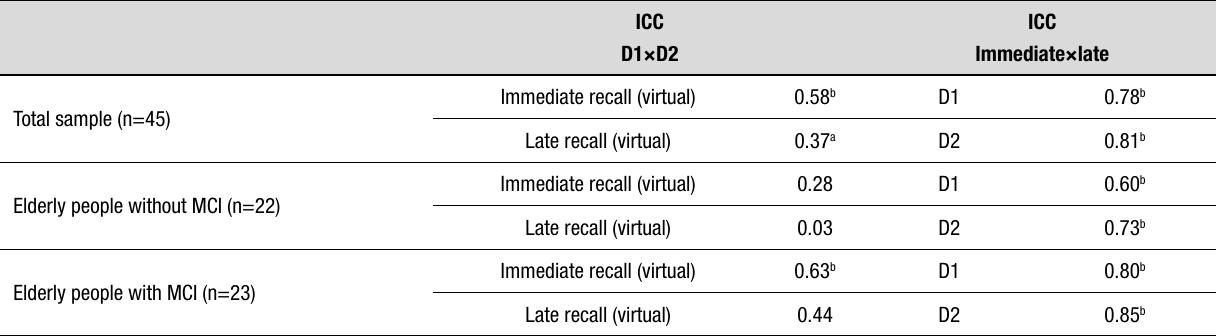
Table 3. Intraclass correlation coefficients between the first and second assessment days and between immediate and late recall performed on the same day of the SOIVET-Route